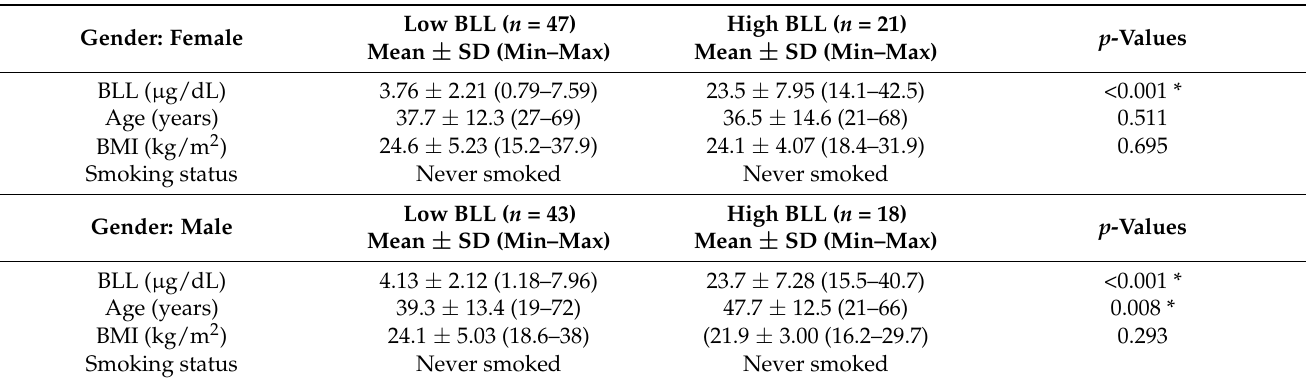
Table 1. The BMI and age characteristics were as listed in Table 1. Table 1. General characteristics of adult female and male subjects